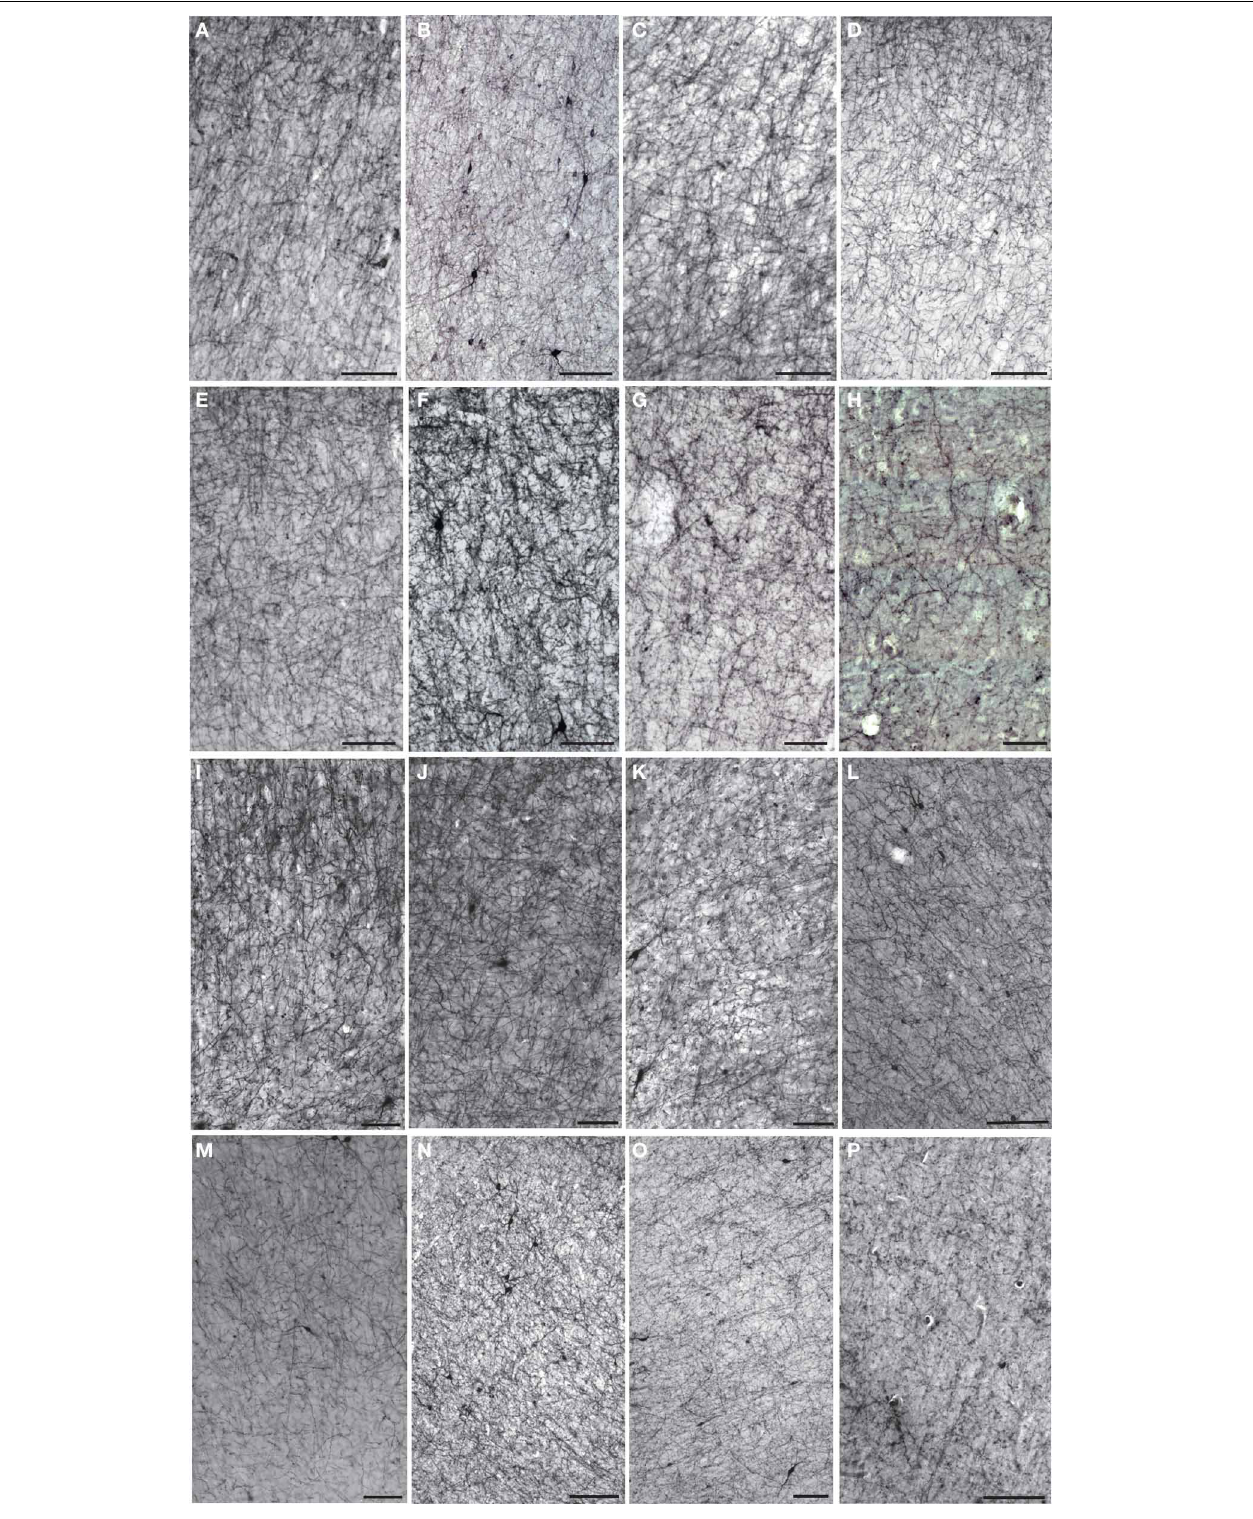
FIGURE 2 | Low-powered photomicrographs of NPY immunostaining in layer III (A–H) and layers V–VI (I–P) of area 10. (A,I) squirrel monkey, (B,J) capuchin, (C,K) moor macaque, (D,L) pigtailed macaque, (E,M) baboon, (F,N) gorilla, (G,O) chimpanzee, (H,P) human. Scale bars = 100 μ m.